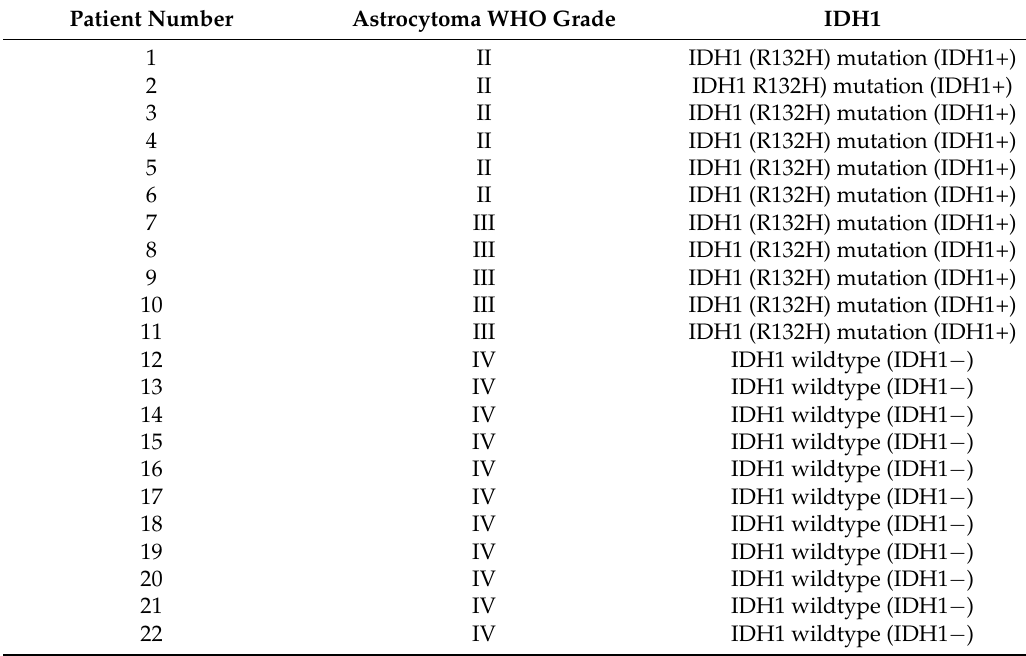
Table 2. World Health Organization (WHO) grading and IDH1 (isocitrate dehydrogenase 1 (NADP(+)) status of